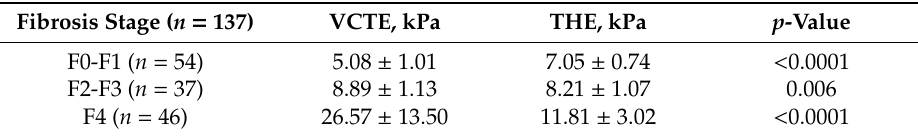
Table 2. Mean values of liver sti ff ness for each fibrosis stage by THE and VCTE. Fibrosis Stage ( n = 137) VCTE, kPa